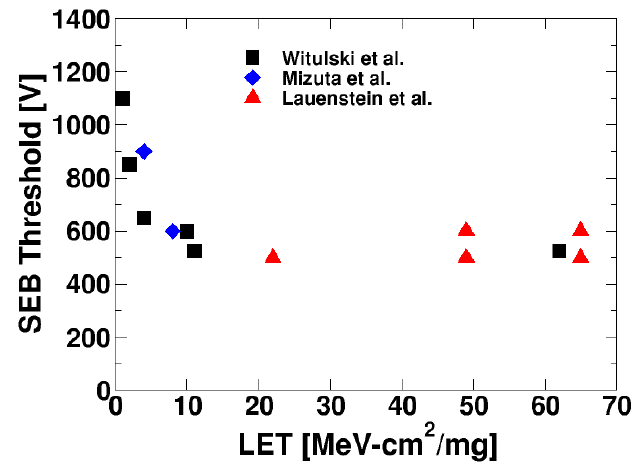
Figure 1. Experimental measurements of single event burnout (SEB) threshold voltage versus heavy-ion linear energy transfer (LET) for 1200 V SiC Power metal-oxide-semiconductor field effect transistors (MOSFETs). Data from [9–11].